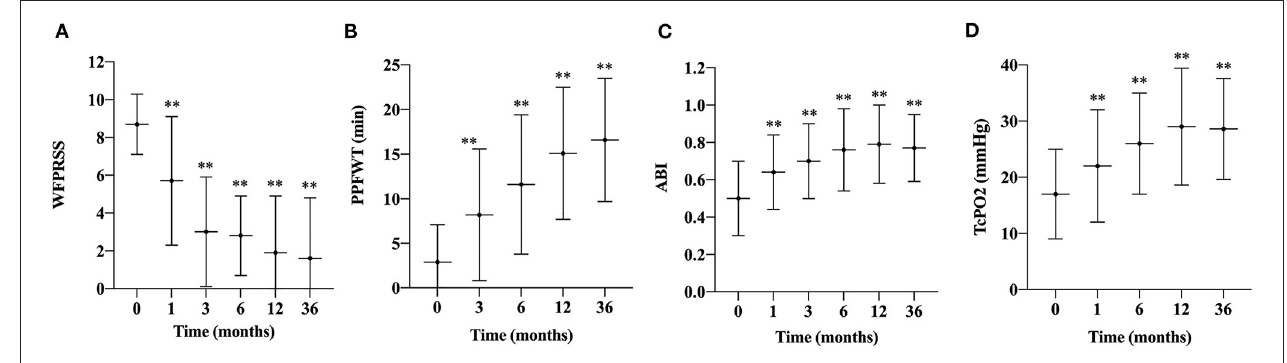
FIGURE 3 | Changes in WFPRSS, PPFWT, ABI, and TcPO 2 during the follow-up. Changes in the WFPRSS (A) , PPFWT (B) , ABI (C) , TcPO 2 , (D) in patients after treatment of PBMNCs are depicted as linear graphs with mean values and the SD bars. (**, P < 0.01). WFPRSS, Wong-Baker FACES pain rating scale score; PPFWT, peak pain-free walking time; ABI, ankle-brachial index; TcPO 2 , transcutaneous partial oxygen pressure; SD, standard deviation.